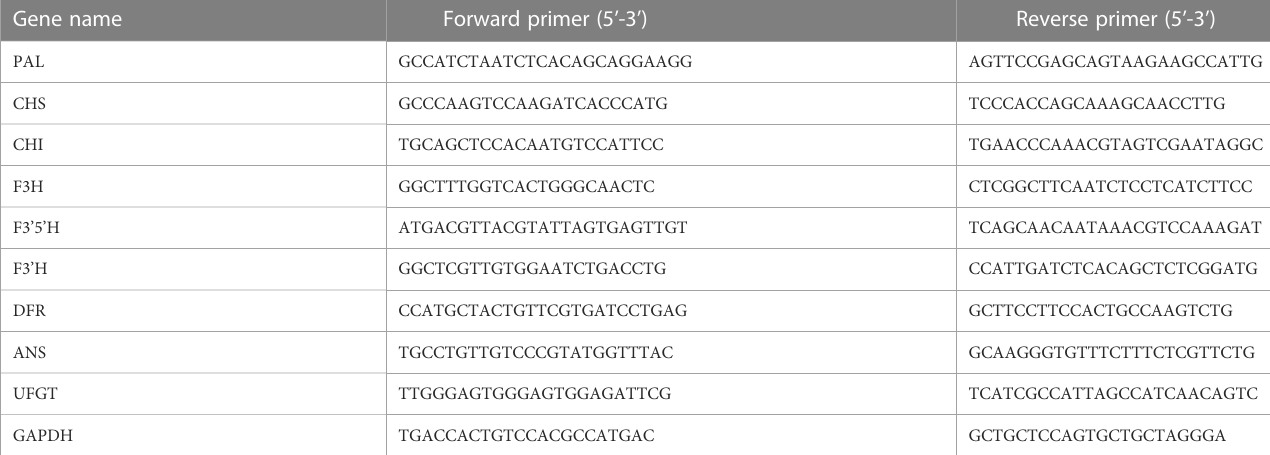
TABLE 1 Primer sequences for qRT PCR reaction of structural